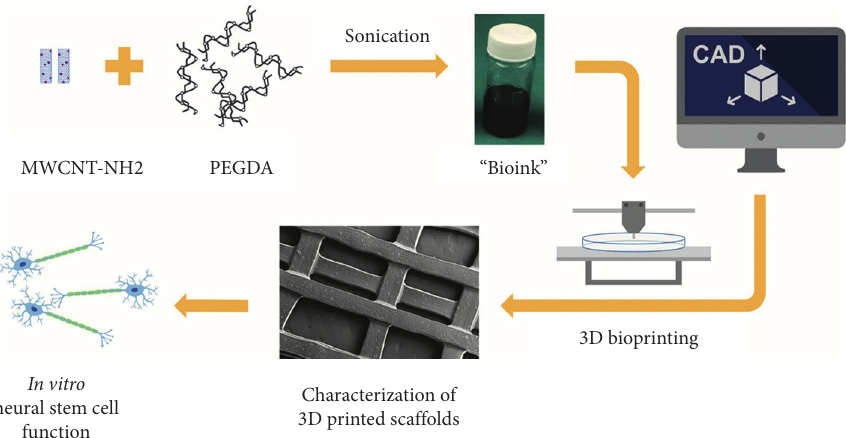
Figure 7: Representation of the manufacturing process of 3D-printing nanoconductive MWCNT-PEGDA scaffolds